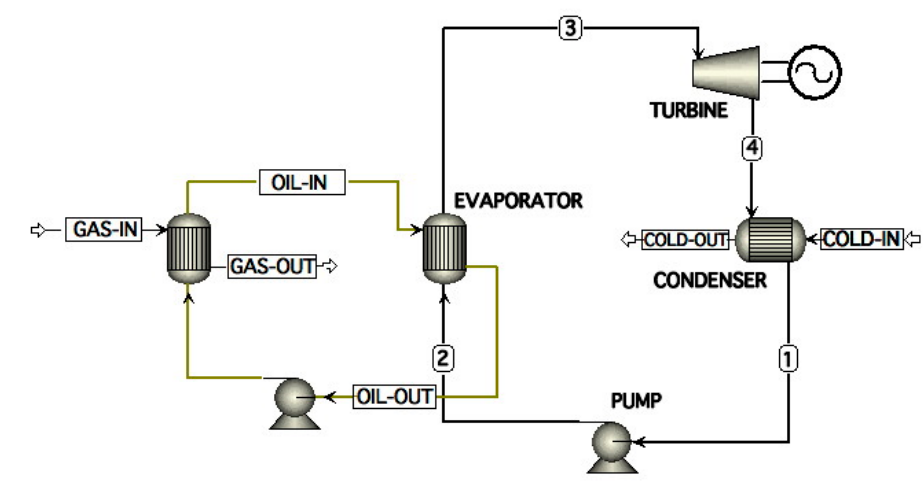
Figure 3. Flowchart of simple ORC circuit.